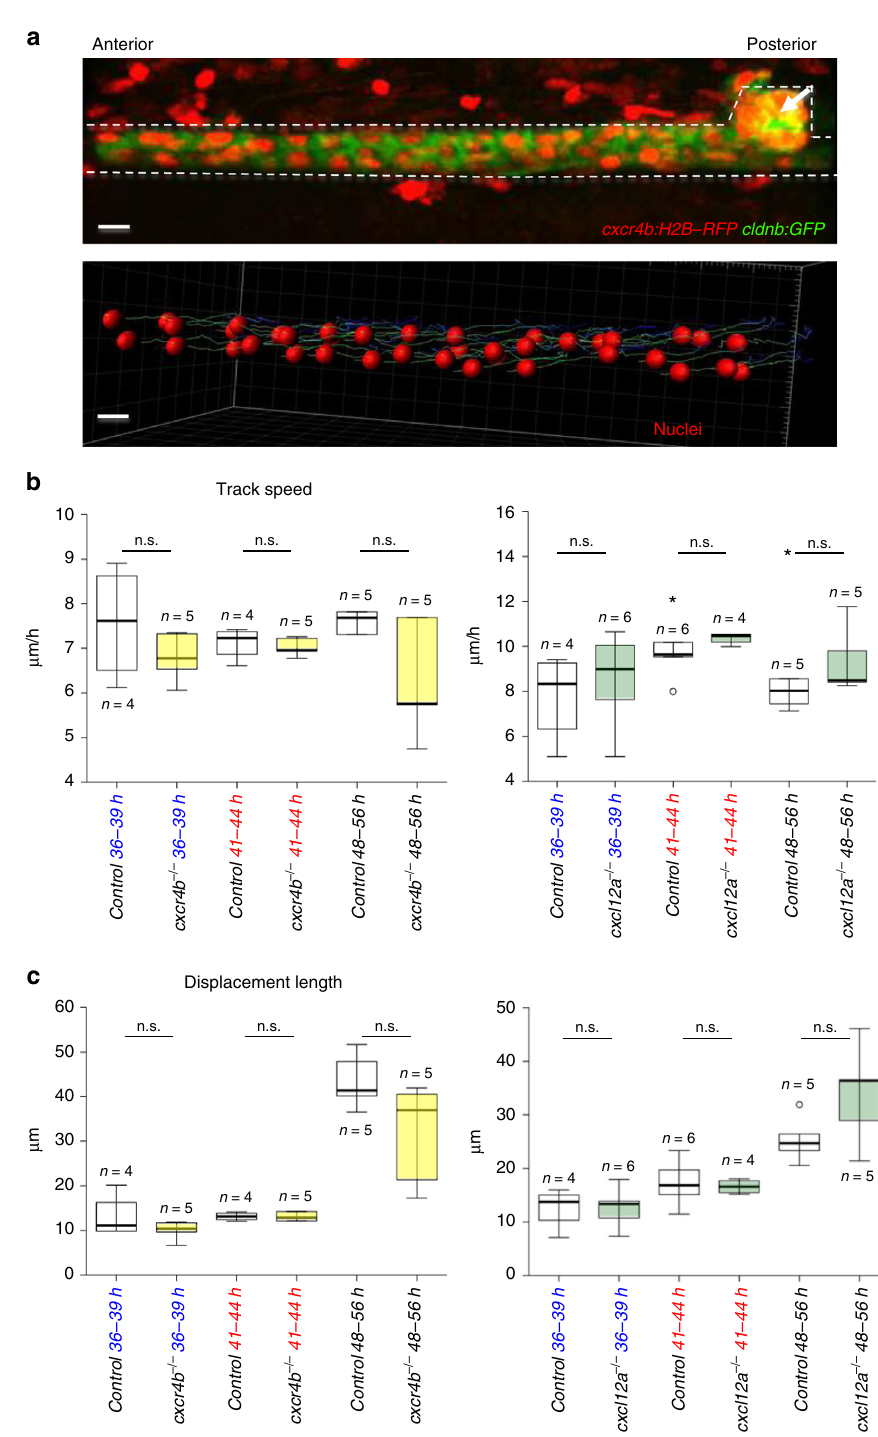
Fig. 3 cxcr4b or cxcl12a deletion does not affect pronephros cell migration. a Collective cell migration in the zebra fi sh pronephros was quanti fi ed, using a cxcr4b:H2B-RFP; cldnb:GFP double transgenic zebra fi sh line (upper panel, see Supplementary Movie 4). The transgene cxcr4b:H2B-RFP labels the nuclei of cells that express RFP under the control of the endogenous cxcr4b promoter; cldnb:GFP labels the membranes of pronephric duct cells. The pronephros and the corpuscle of Stannius are outlined with dashed lines. The arrow points to the corpuscle of Stannius (scale bars, 10 µ m). A model of collective cell migration was generated (lower panel), using the image tool Imaris. The migration of ca. 40 pronephric nuclei was tracked over 8 h, starting 48 hpf. The tracks for each cell were calculated and represented as lines. The observation times were coded by blue-to-green colors; blue are early time points and green are later ones (see Supplementary Movie 5). b The mean track speed and displacement length, i.e., the length that a cell traveled over the observation period were measured at 36 and 41 hpf for 3 h, and at 48 hpf for 8 h. De fi ciency of cxcr4b (left panel) or cxcl12a (right panel) did not affect track speed (left panel). c De fi ciency of cxcr4b (left panel) or cxcl12a (right panel) did not affect displacement length. Note that the displacement length is larger in the 48 – 56-hour-interval, because cells were tracked for a longer time period (8 h) in comparison with the earlier time points (3 h each). In contrast, the speed did not change signi fi cantly over time (n.s., not signi fi cant; t